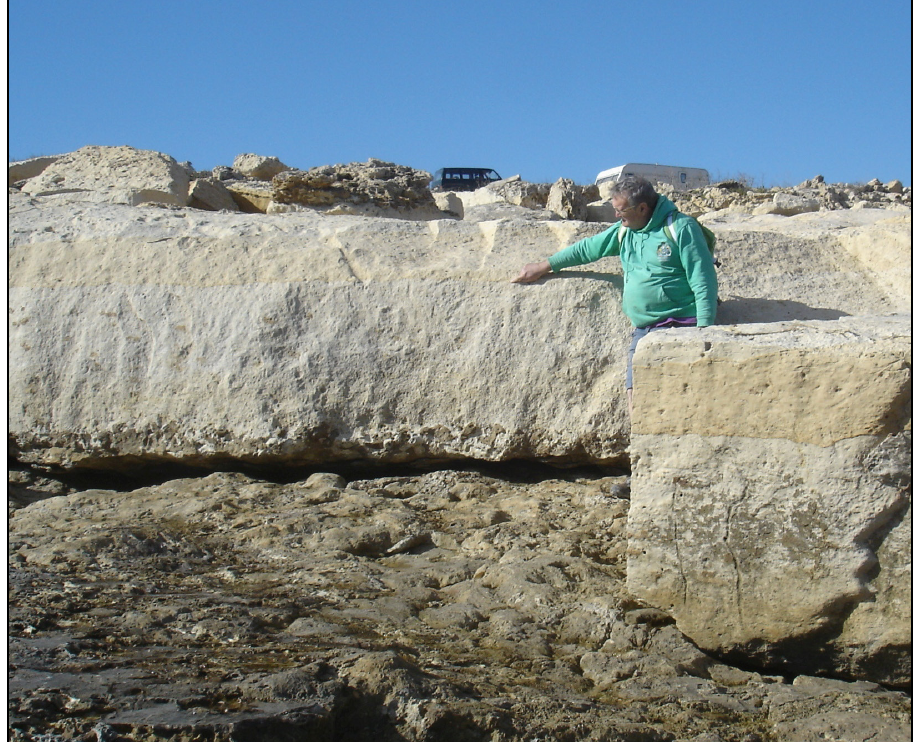
Figure 4. The Lower Globigerina Limestone (LGL) scarp, here overhanging the basal notch associated with the Phosphoritic Conglomerate Bed (PCB) that in places extends horizontally to a depth of up to 3.5 m. The fallen rock mass (right) has become detached from the scarp face and now rests directly on the shore platform beneath. The stratigraphic boundary clearly visible in the fallen mass can be matched with its in situ counterpart pointed out on the scarp face, indicative of both the height of the notch and the depth of the fall. The knobbly surface of the shore platform is characteristic of Lower Coralline Limestone (LCL). Large boulders are present on the ramp surface above the scarp, including a prominent inverted boulder (PCB bed facing upward) just left of